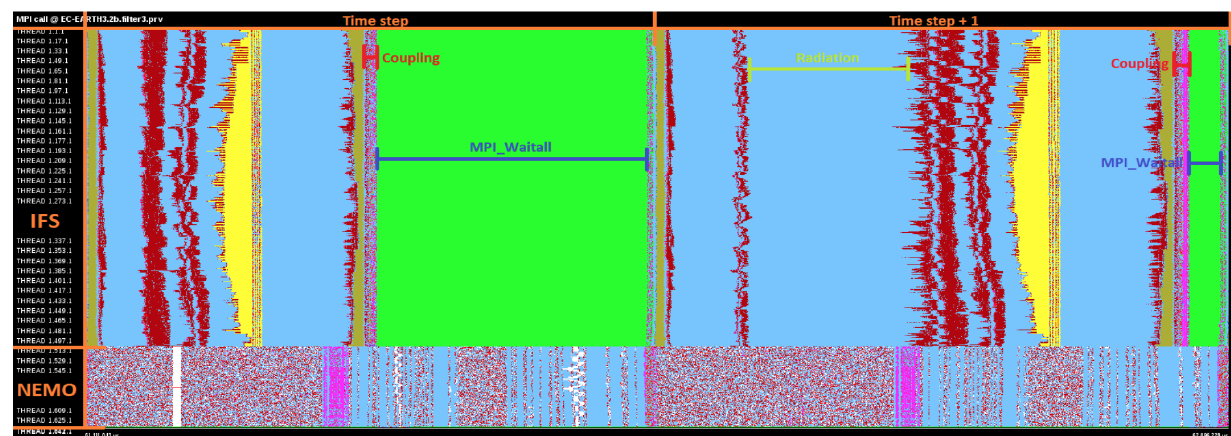
Figure 8. Example trace information generated with EXTRAE used to analyse high-resolution coupling in EC-Earth. This view shows MPI calls during the execution (one colour per call). Top: 512 MPI tasks for the IFS atmospheric model. Bottom: 128 MPI tasks for the NEMO ocean model. This fine-grained performance information yields information as to how to get better performance out of coarse-grained